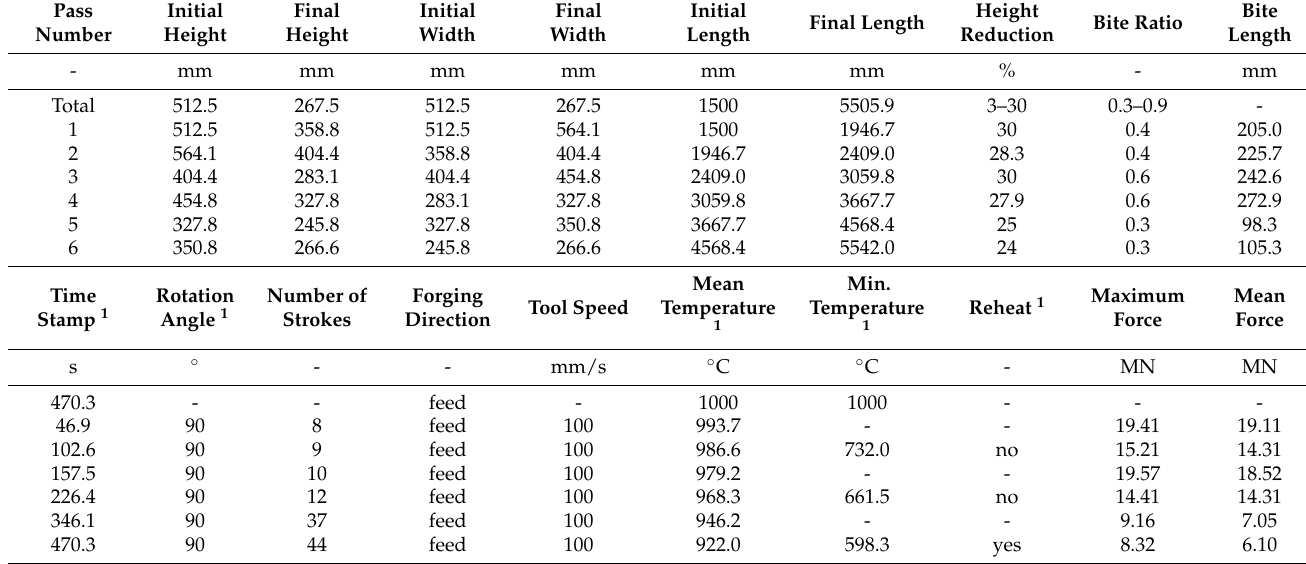
Table 4. The pass schedule example generated using the overall best agent (training 15, iteration 45,000). Pass Initial Number